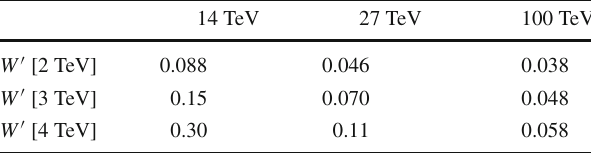
Table 5 Value of the W (cid:2) coupling for which there is 5 σ sensitivity, for different masses and collider